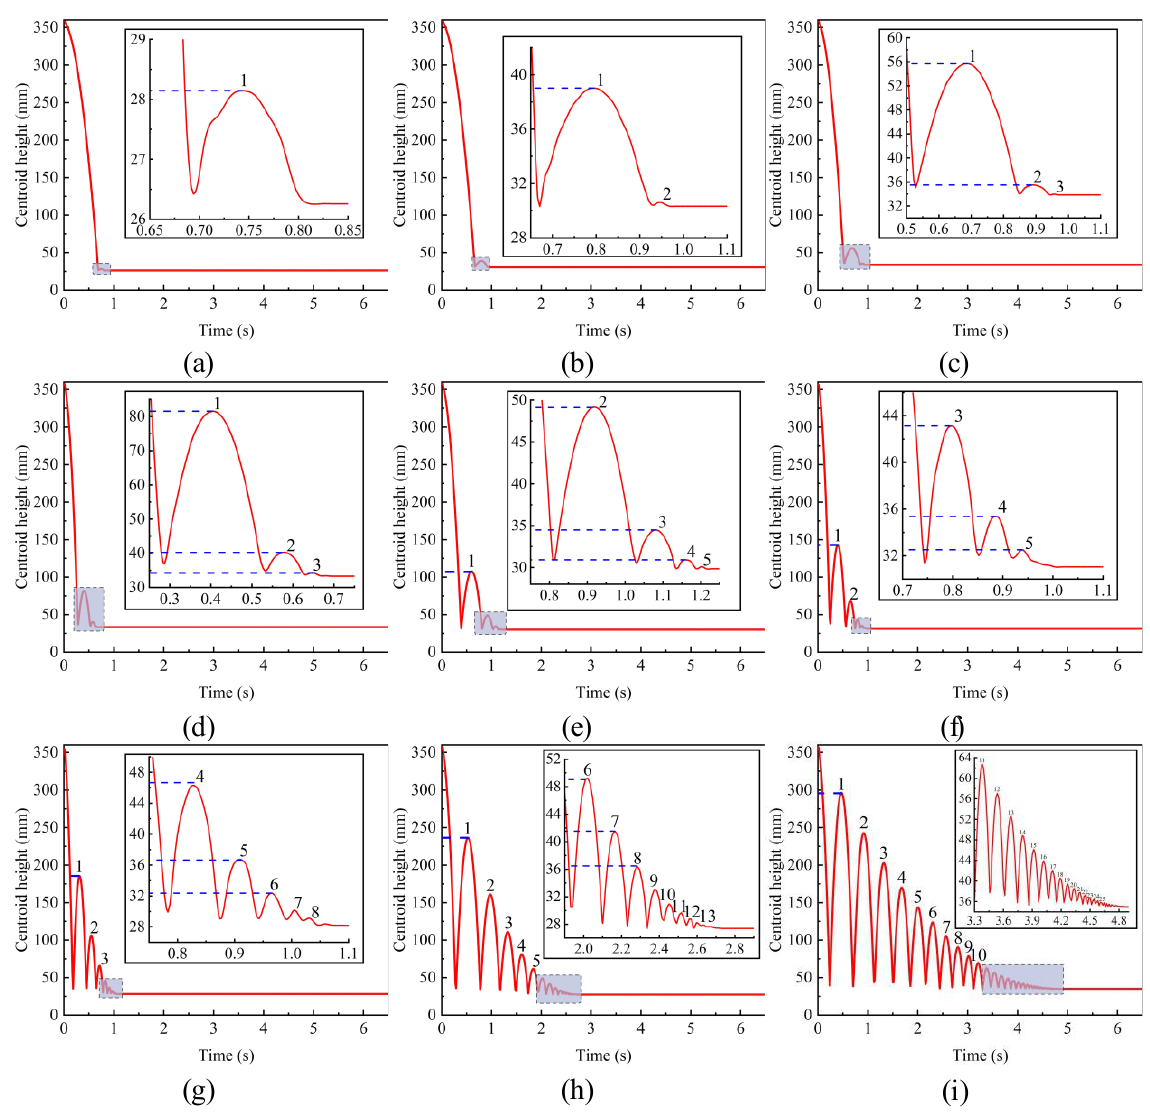
Figure 4. Rebound height with different RCs; ( a ) η = 0.1; ( b ) η = 0.2; ( c ) η = 0.3; ( d ) η = 0.4; ( e ) η = 0.5; ( f ) η = 0.6; ( g ) η = 0.7; ( h ) η = 0.8; ( i ) η = 0.9. ( f ) η = 0.6; ( g ) η = 0.7; ( h ) η = 0.8; ( i ) η =